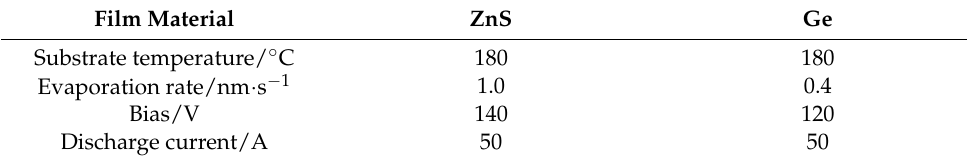
Table 1. The deposition parameters of thin films.